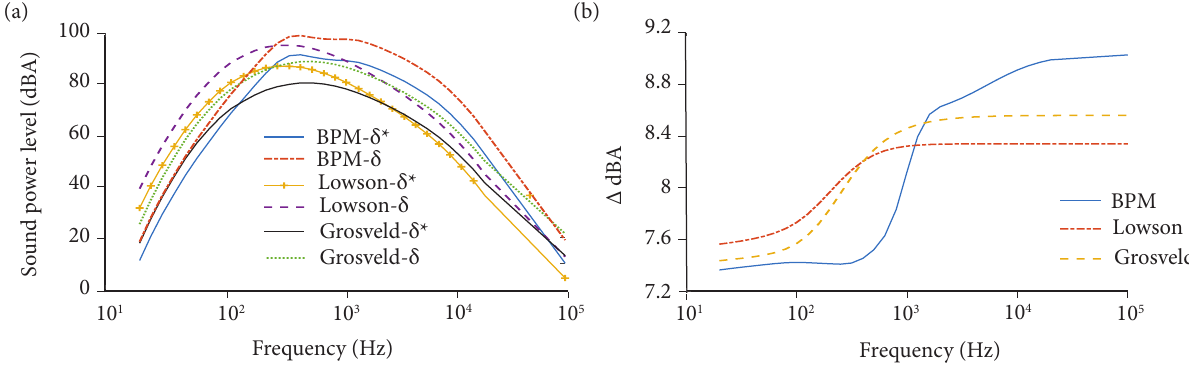
Figure 2. (a) Comparison of frequency spectra of TBL-TE, A-weighted sound power level using BPM, Grosveld and Lowson models at free stream velocity, U = 10 m/s; (b) Δ dBA, between thickness δ , displacement thickness δ * at free stream velocity, U = 10 m/s, receiver height of 2 m and at distance of ~120 m, i.e. total turbine height (HH +